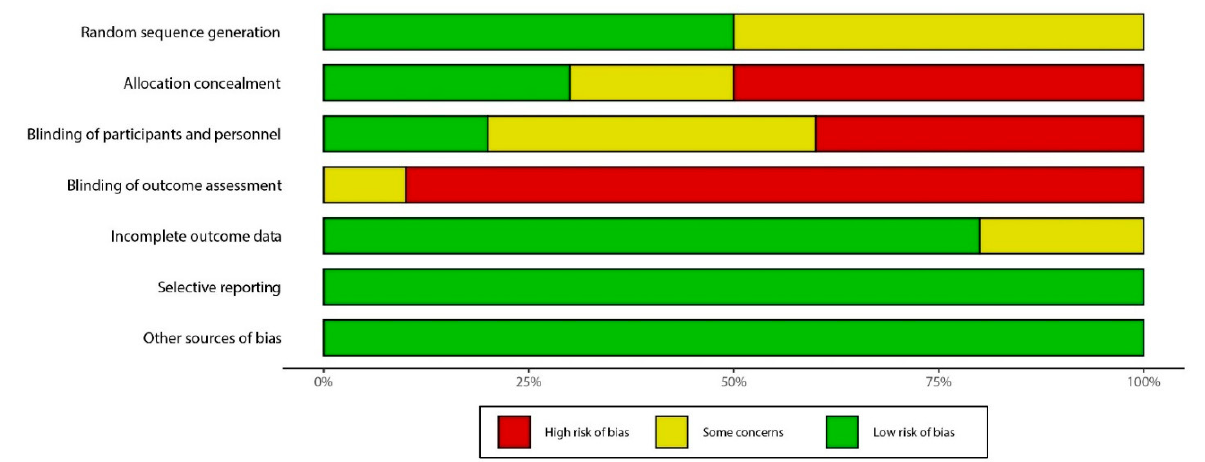
Figure 3. Study quality and risk of bias assessment of included studies in the meta − analysis (summary).